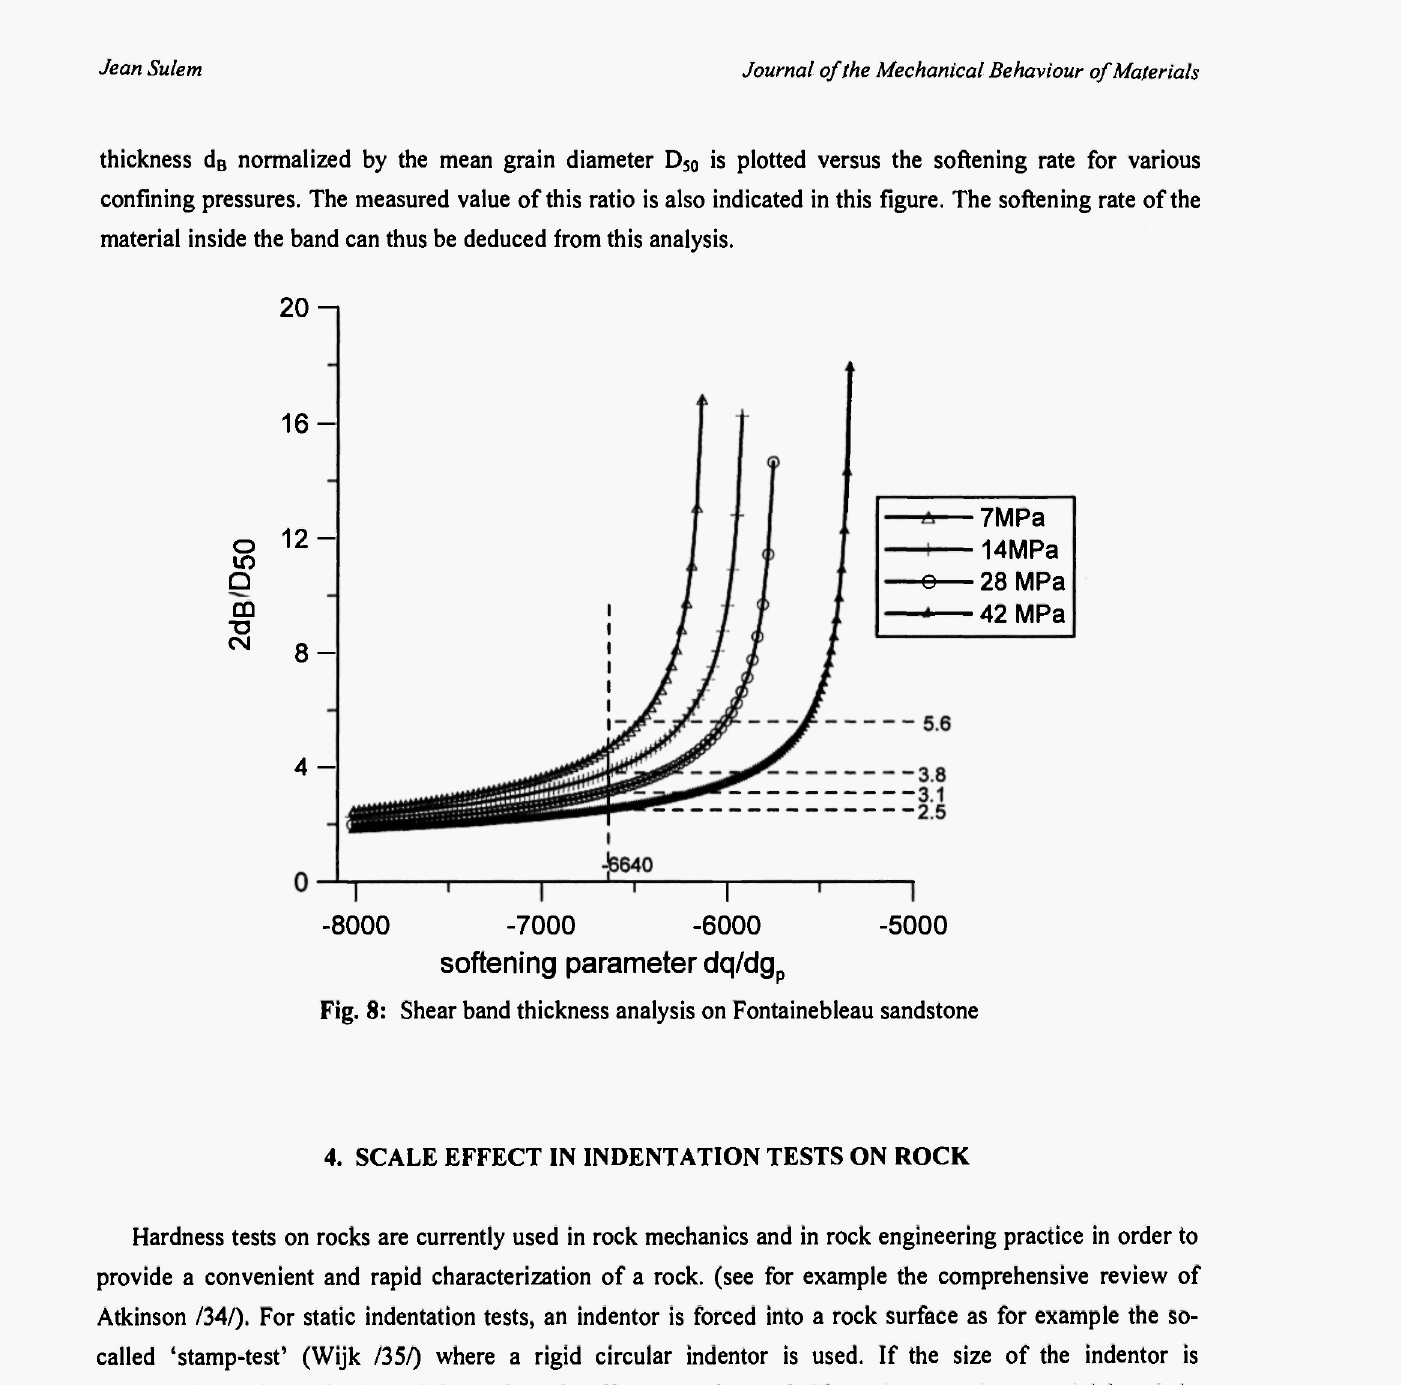
Fig. 8: Shear band thickness analysis on Fontainebleau